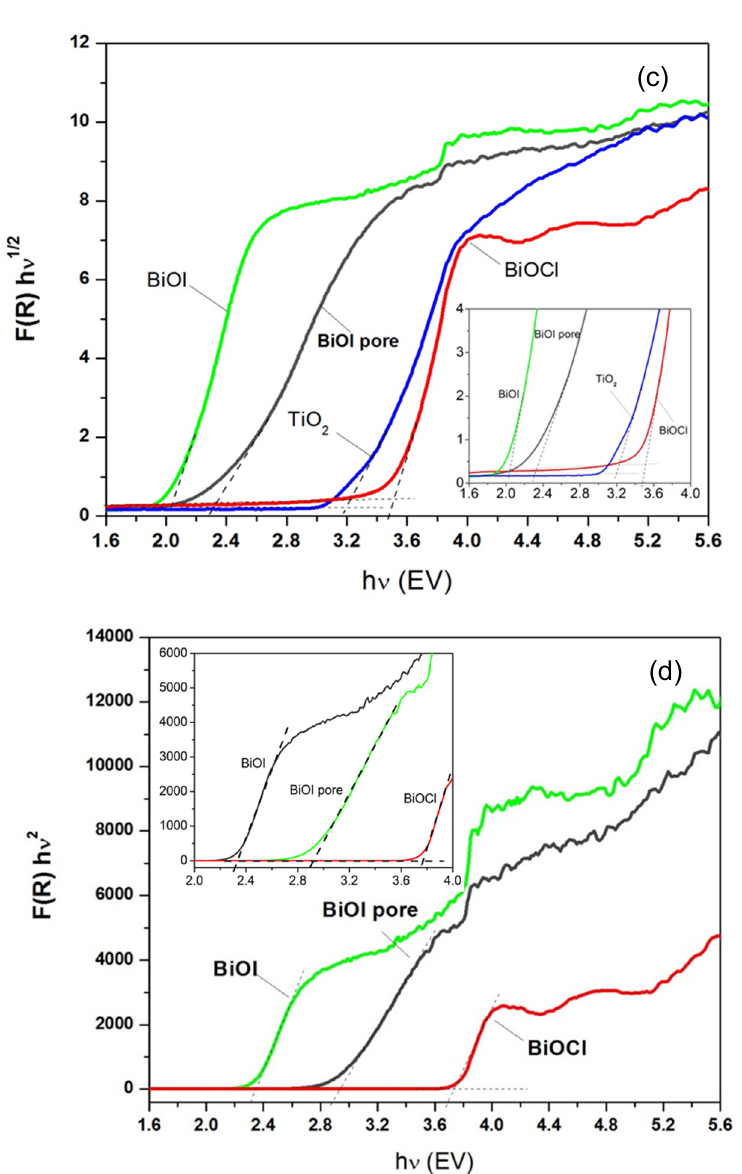
Figure 10. Kubelka–Munk absorption curves of ( a ) pure-photocatalysts and ( b ) cement-based.samples, Figure 10. Kubelka – Munk absorption curves of ( a ) pure-photocatalysts and ( b ) cement- ( c ) plots of (FR hv ) 1 / 2 vs. photon energy ( hv ) for pure-photocatalysts (indirect transitions), and ( d ) plots based.samples, ( c ) plots of (FR h ʋ ) 1/2 vs. photon energy ( h ʋ ) for pure-photocatalysts (indirect of (FR hv ) 2 vs. photon energy ( hv ) for pure-photocatalyst (direct transitions), and ( d ) plots of (FR h ʋ ) 2 vs. photon energy ( h ʋ ) for pure-photocatalyst (direct transitions).